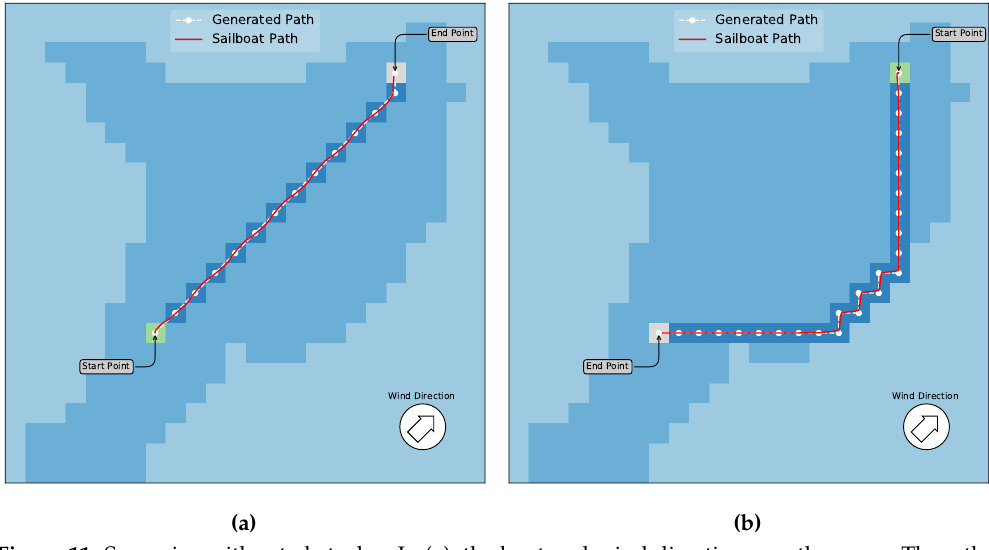
Figure 11. Scenarios without obstacles. In ( a ), the boat and wind directions are the same. Thus, the generated path can be done using all directions. The red line is the sailboat trajectory performed by the simulator with the path given by the algorithm. In ( b ), once the boat direction is contrary to the wind, a zigzag trajectory is generated. Note that the action down-left is not allowed in this